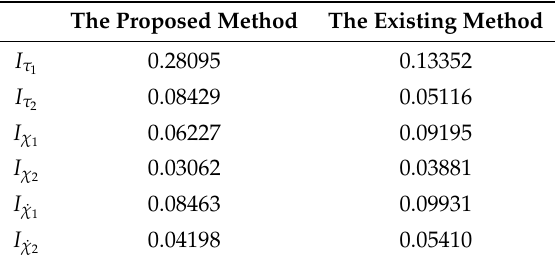
Table 1. Comparative results between the proposed method and the existing method [35]. The Proposed Method The Existing